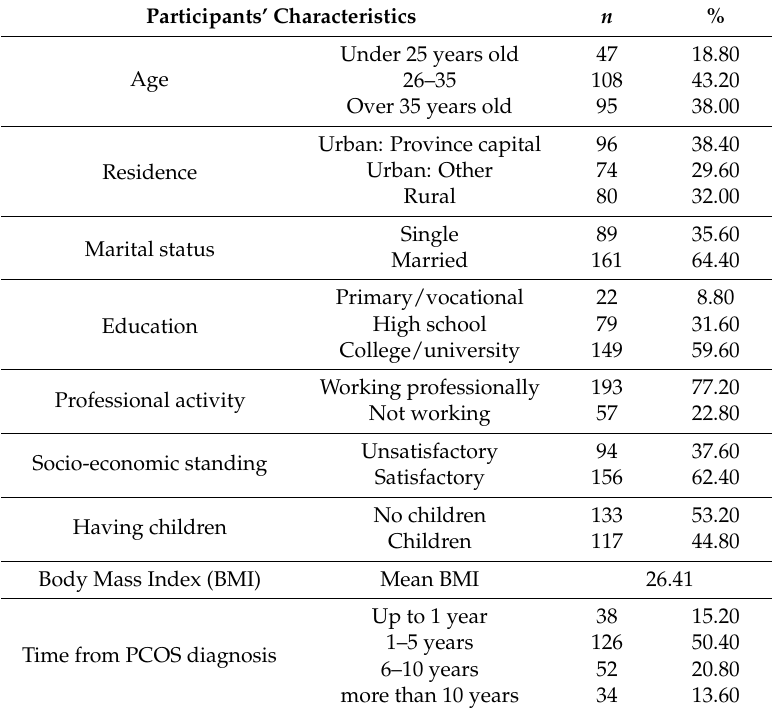
Table 1. Participants’ characteristics.